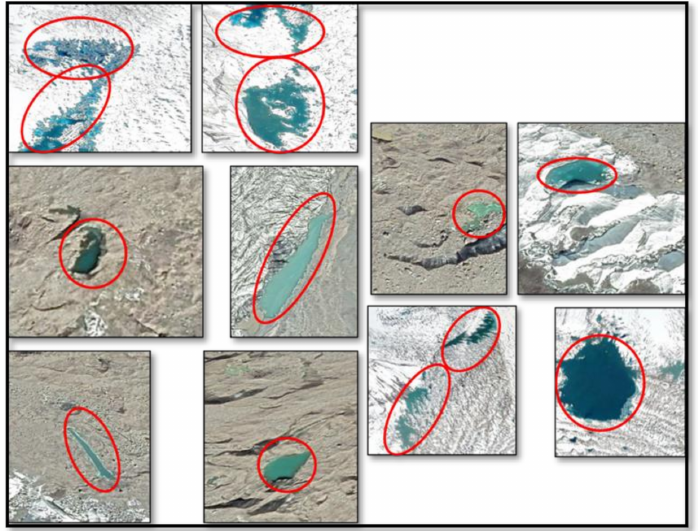
Figure 13. Supra-glacial lakes with debris-covered ice and clean ice from high-resolution Google Earth image, 2020. Red circles show supra-glacial lakes.